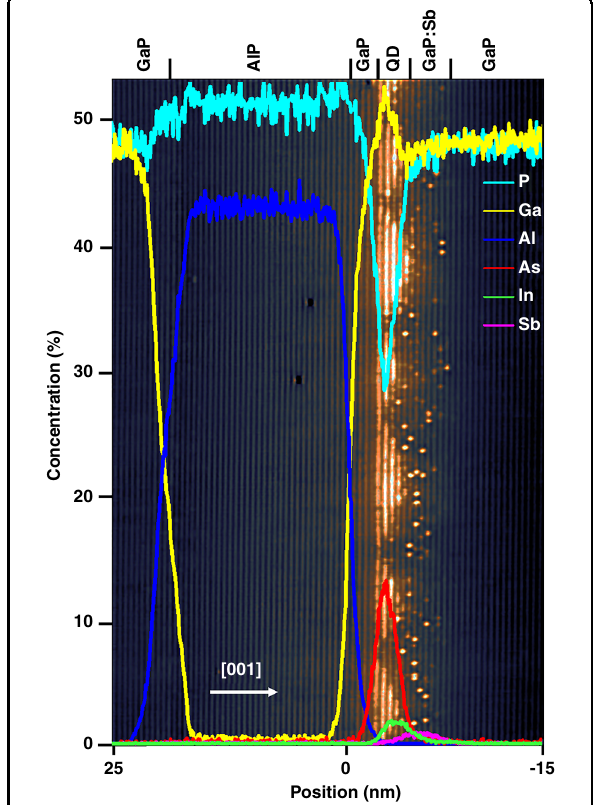
Fig. 4 The APT concentration pro fi les of all the constituent elements (P, Ga, Al, As, In, and Sb) overlaid on top a 40×60nm 2 topographic fi lled-state X-STM image for better visualization and comparison. The apparent non-stoichiometry of the AlP layer is due to the unresolvable identi fi cation issue of complex phosphorus species in the 31Da peak, as described in “ QDs: composition ” section. The arrow indicates the growth direction [001] and the different regions are indicated on top of the image